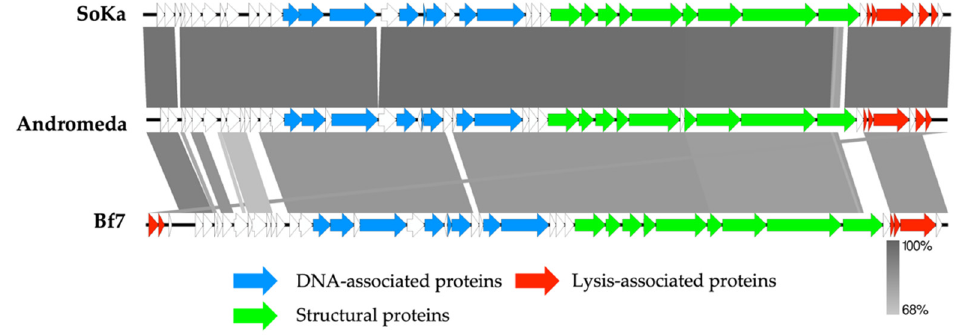
Figure 4. Genome map of the sequenced Pseudomonas phage SoKa and comparison (greyscale) to the closest related phages, Andromeda and Bf7, using BLASTn analysis. Each arrow represents a coding sequence. In red—genes encoding packaging and lysis-associated proteins are displayed; in green—structural proteins; in blue—DNA- and metabolism-associated proteins (adapted from EasyFig).